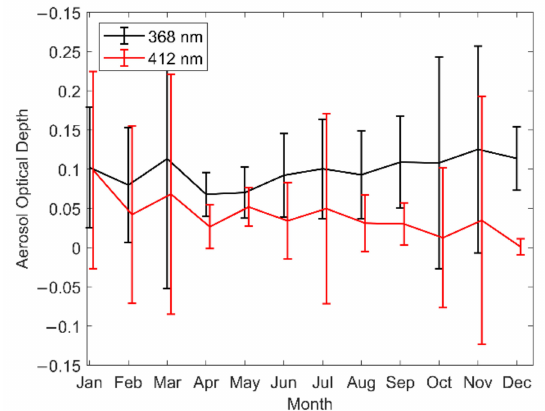
Figure 3. Monthly mean and ± 1 standard deviation (SD) error bars of aerosol optical depth (AOD) from precision filter radiometer (PFR) measurements for 368 and 412 nm at Cape Point.